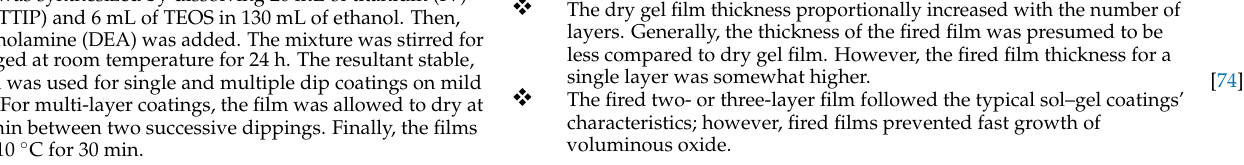
Table 1. Different approaches for improving silane coatings and the main findings, as reported in the literature.